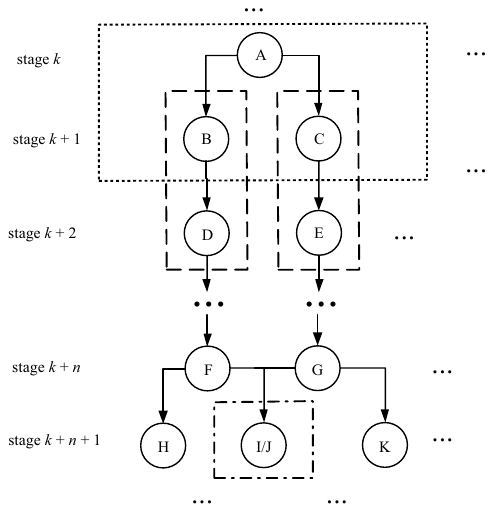
Fig. 3. The illustration of heuristic rules